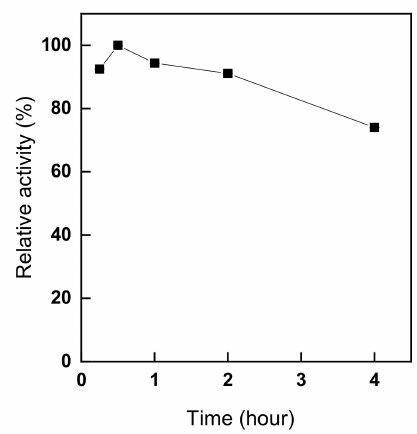
Figure 5. The e ff ects of the immobilization time of trypsin onto glutaraldehyde-pre-activated chitosan nonwoven on the enzyme activity (trypsin immobilization: pH 8.5, trypsin conc. 8% (owf), 25 ◦ C).